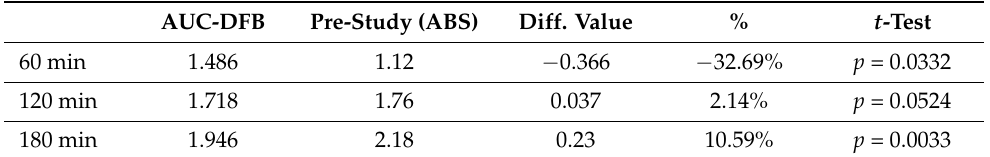
Table 7. RMSE comparisons between the ABS model and the AUC-DFB model using all predicted values in the range of the horizon, i.e., all predictions between 0 and 180 min for the 180 min prediction. A negative difference means that the error increased. All values are in